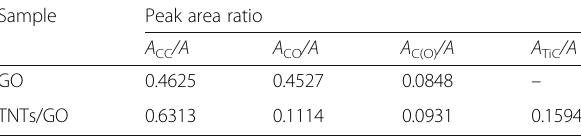
Table 1 Peak area ( A ) ratios of the oxygen-containing bonds to the total carbon bonds (obtained by XPS)